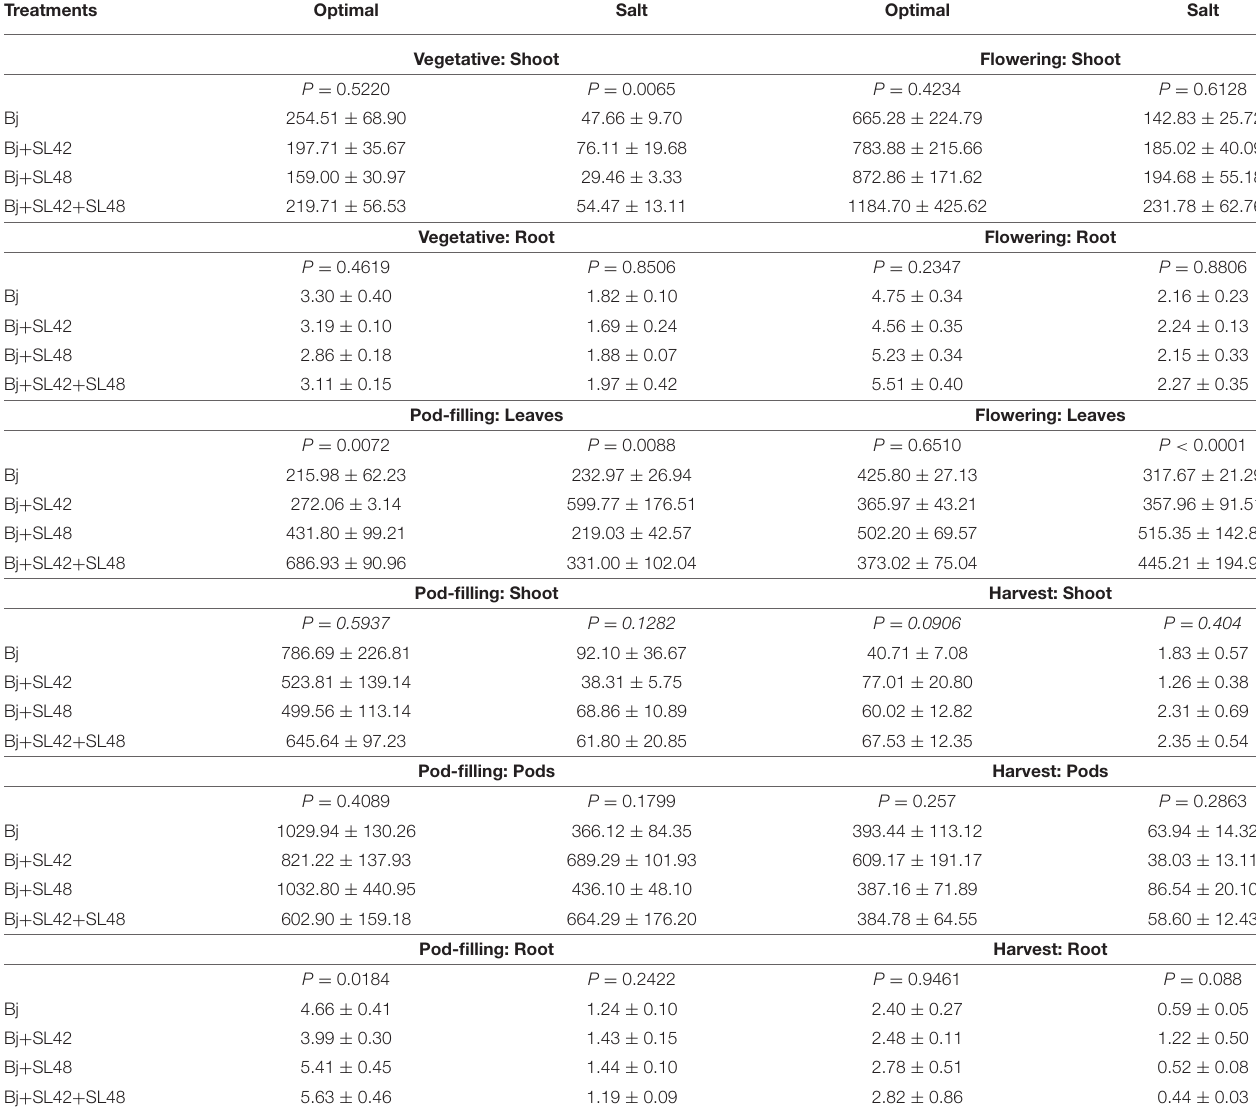
TABLE 3 | Distribution of K + /Na + in different plant tissues through the developmental stages of soybean. Treatments Optimal Salt Optimal Salt Vegetative: